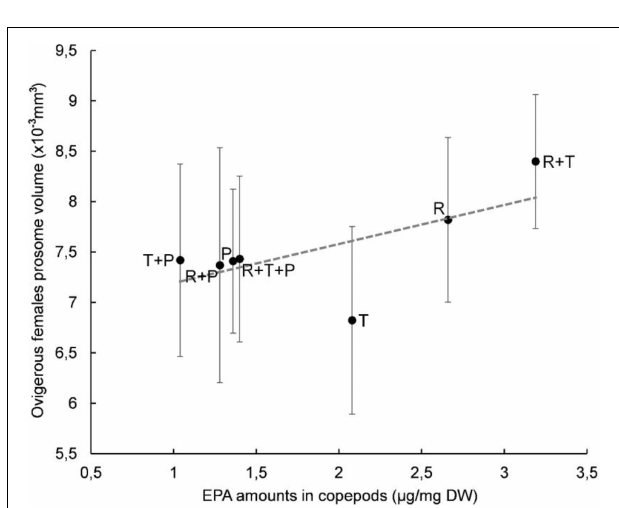
FIGURE 5 | Relationship between average prosome volume and EPA amount in Paracyclopina nana ovigerous females for each microalgal diet. Error bars show the standard deviations obtained from n = 20 females. Dashed line corresponds to the linear regression (EV = 0.387 X PV + 6.8058, R 2 = 0.4202, p < 0.01). Pearson’s test was performed to determine the significance of the coefficient of determination R 2 . R, Rhodomonas salina ; T, Tisochrysis lutea ; P, Pavlova lutheri.